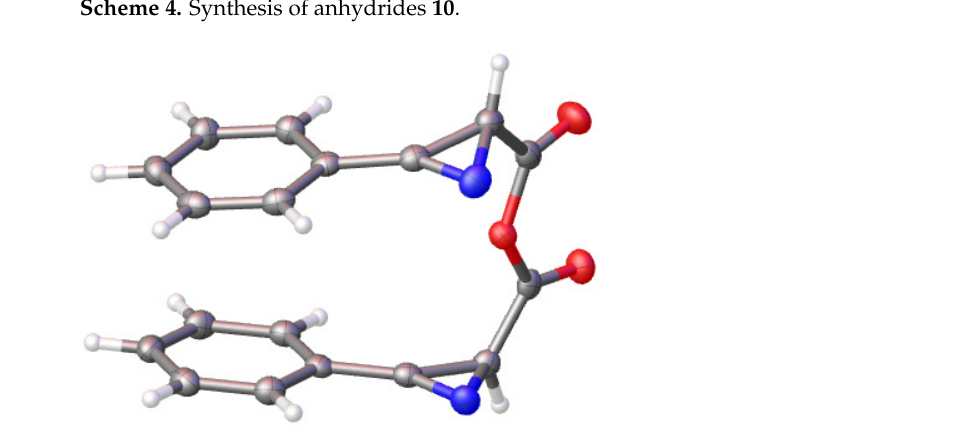
Figure 1. Perspective view of ( RS,SR )-isomer of anhydride 10a showing thermal ellipsoids at 50% probability level.